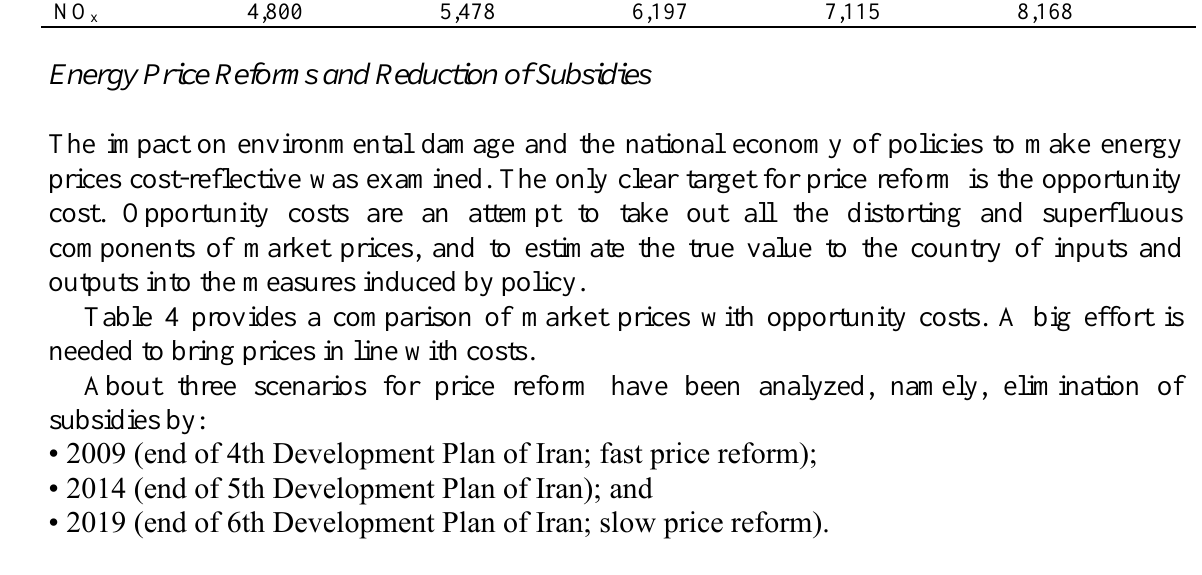
Table 4 . Comparison of market prices and opportunity